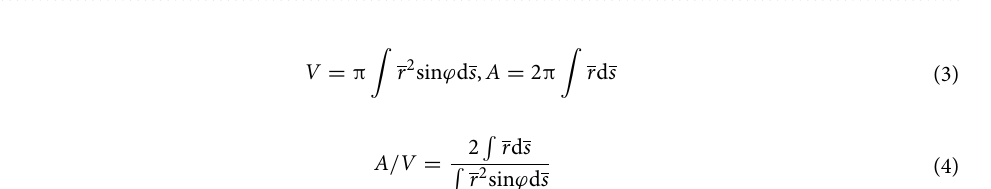
Figure 3. Acquisition process of EGaIn droplet property ( a ) EGaIn droplet image extraction. ( b ) Analysis of EGaIn droplet